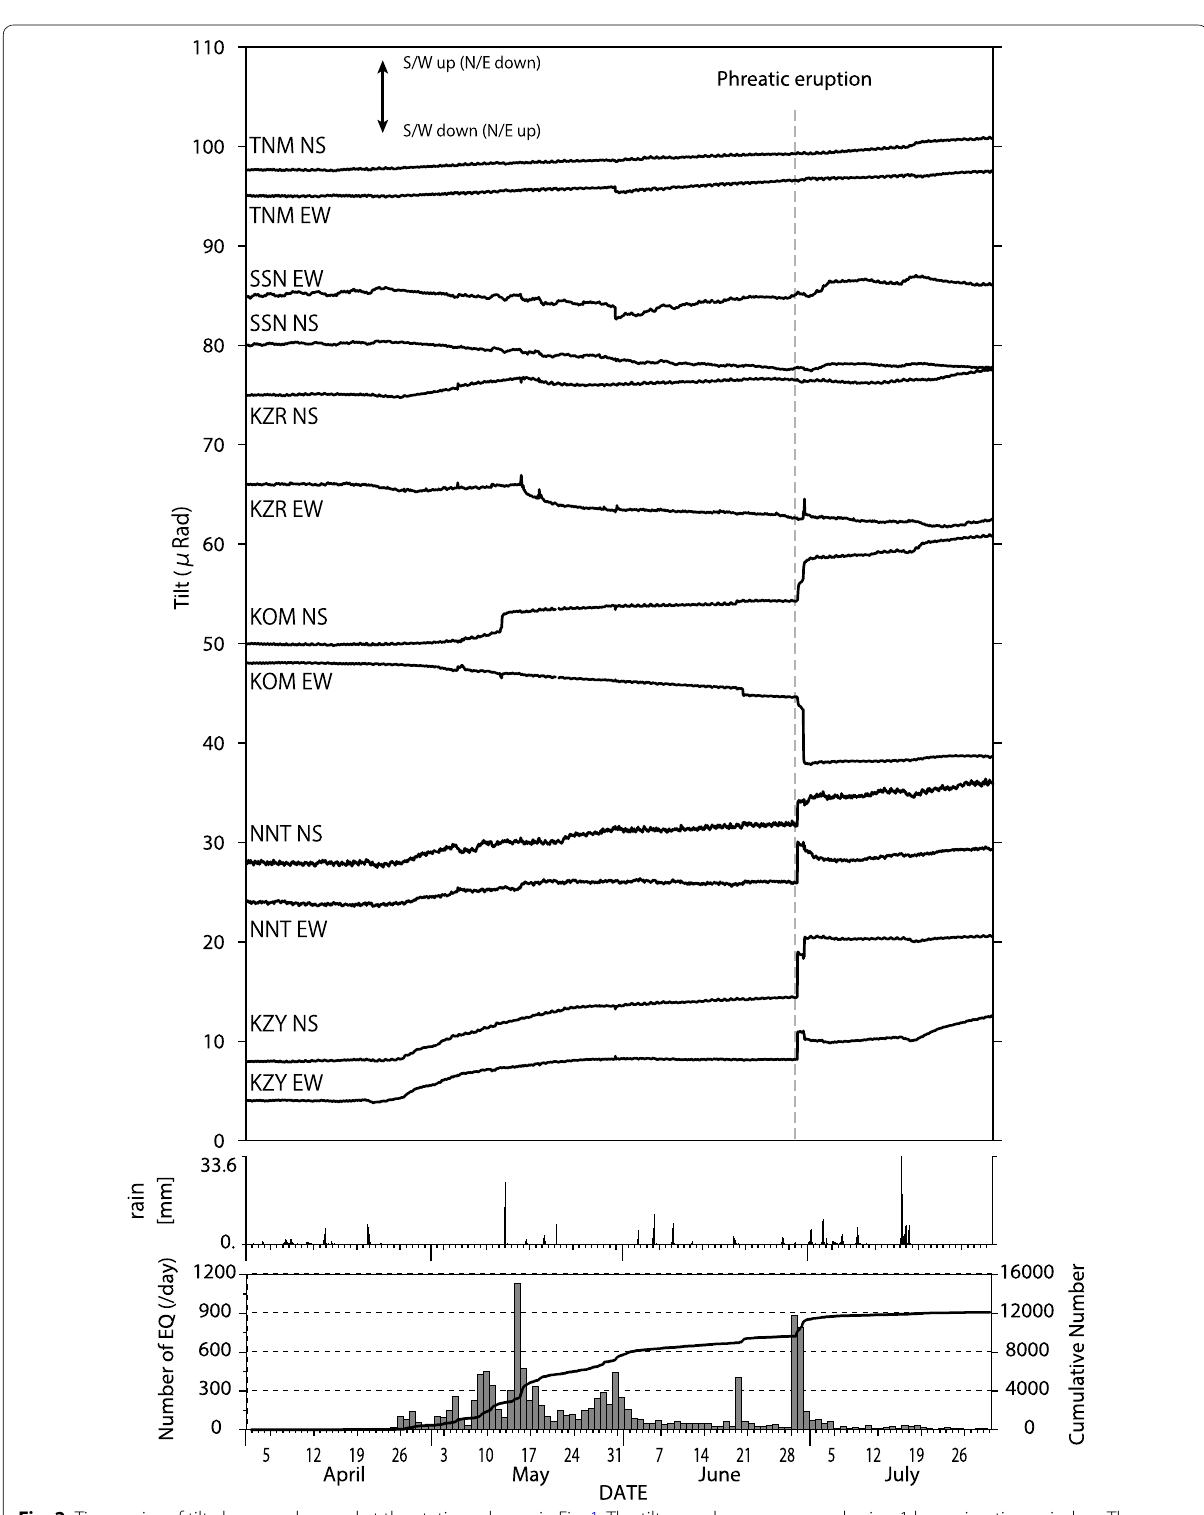
Fig. 2 Time series of tilt changes observed at the stations shown in Fig. 1. The tilt records were averaged using 1 h moving time window. The cumulative number of earthquakes, daily number of earthquakes, and amount of precipitation are also shown. Significant tilt changes were observed on April 26,